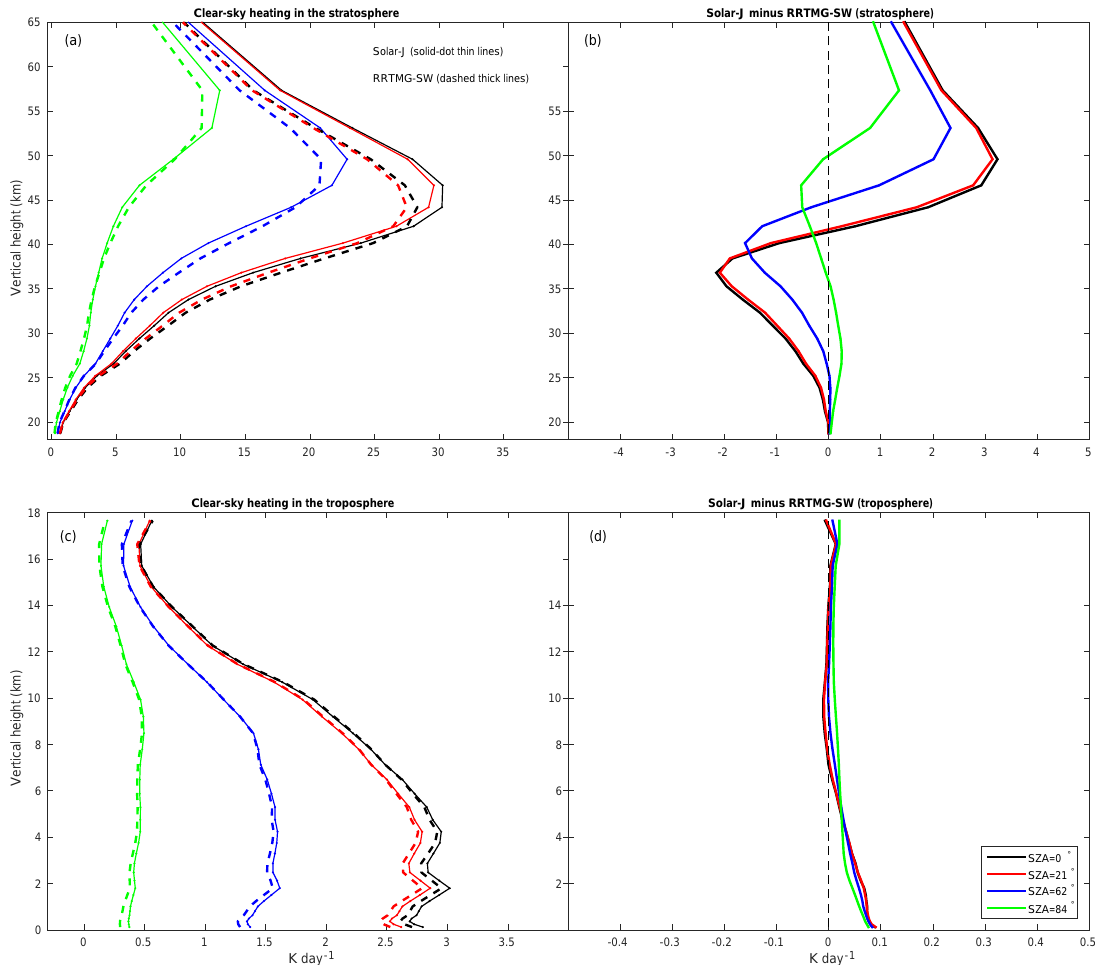
Figure 2. Aerosol-free cloudless atmospheric heating profiles of Solar-J (solid lines) and RRTMG-SW (dashed lines) and the difference, Solar-J minus RRTMG-SW, for a typical July tropical atmosphere at four solar zenith angles with Lambertian surface albedo of 0.06 (left and right sides). The plot is further split into the stratosphere and the troposphere (top and bottom rows). Note that the scale of the x - axis,Kday − 1 , is 10 times larger for the stratosphere on the top